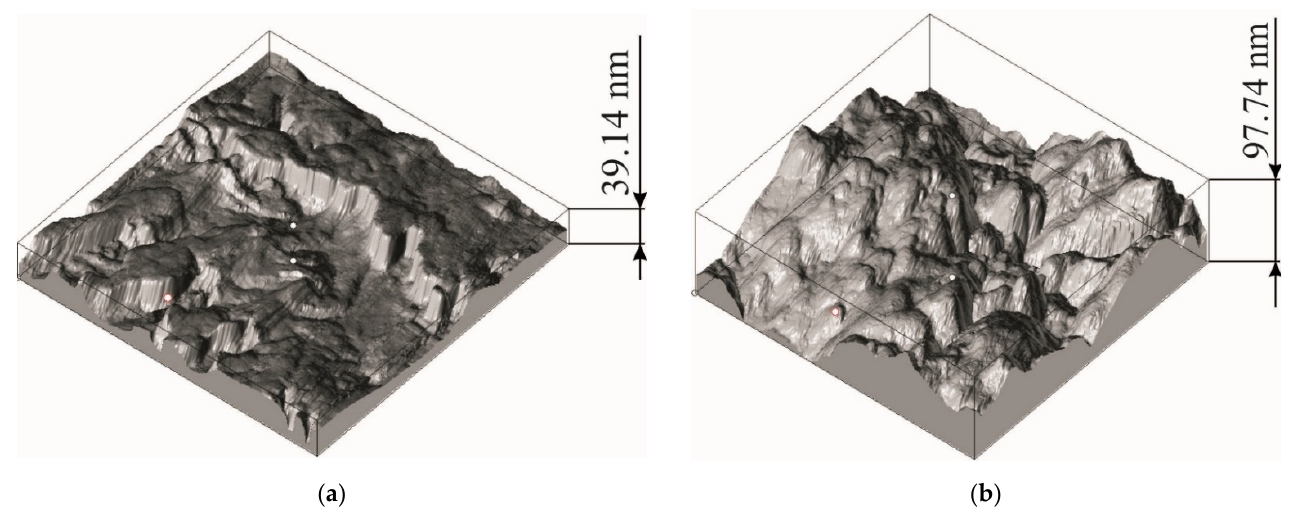
Figure 12. Surface topology (atomic force microscopy) of specimens of 45 steel: ( a ) before treatment; ( b ) after cavitation treatment.